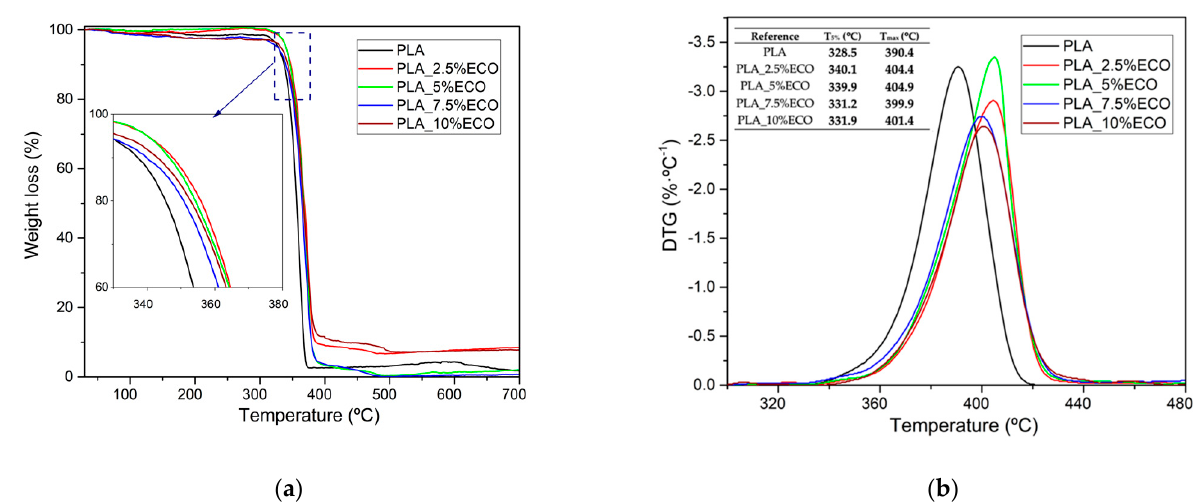
Figure 7. Thermal parameters of degradation of PLA with different epoxidized chia seed oil (ECO) contents. ( a ) Weight loss; ( b ) derivative thermogravimetry. T 5% is temperature at 5% weight loss; T max is temperature at maximum degradation.